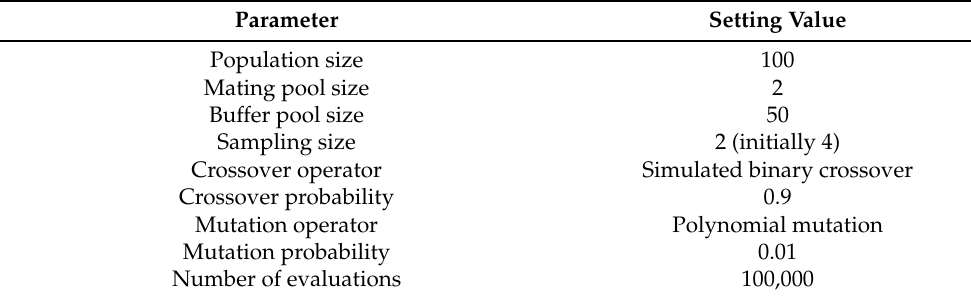
Table 4. Parameter setting of NTGA in our experiments.